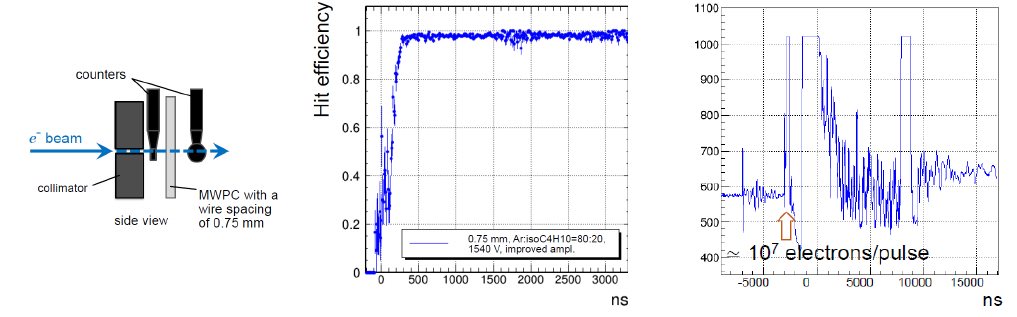
Figure 8: Setup (left) and hit efficiency of the MWPC (right) obtained from the test at Institute for Integrated Radiation and Nuclear Science, Ky- oto University.